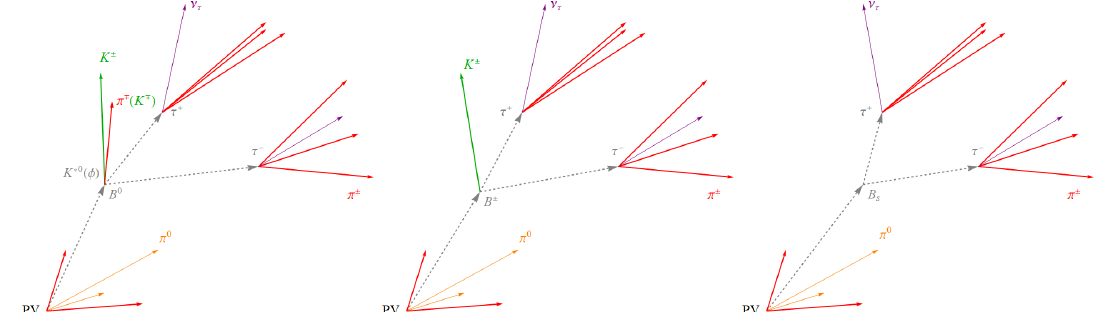
Figure 1 . Schematic pictures of the B 0 → K ∗ 0 ( φ ) τ + τ − (left), B + → K + τ + τ − (middle) and B s → τ + τ − (right) events. The dashed arrows represent spatial displacement of B mesons and τ leptons between their production and decay vertexes ( ~V ), and the solid ones denote three-momenta ( ~p ) of their decay products or accompanying